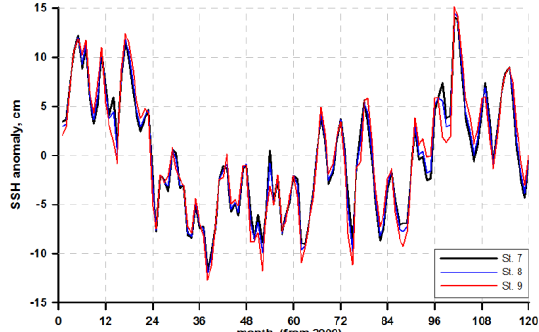
Figure 4. The sea surface elevation from the global model FESOM1.4 simulation [38] for Stations 7–9 shown in Figure 2 .